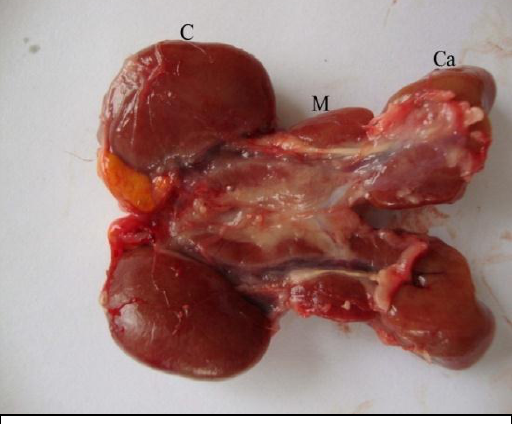
Fig. 3: photograph illustrates anatomical position, shape and color of kidney (ventral view). O. ovary, L. lung, Ov. Oviduct, Uureter, C. cranial, M. middle and Ca. caudal lobe.